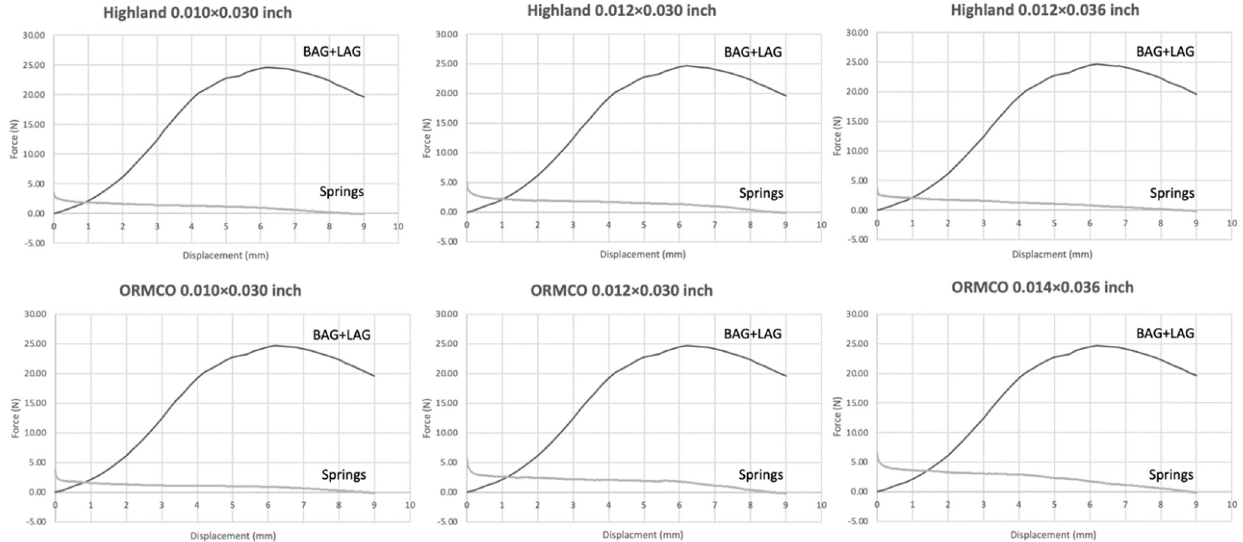
Figure 8. Combined load–displacement curves from the tensile tests of porcine attached gingiva with the unloading forces of the NiTi open–coil springs of different manufacturers and dimensions.